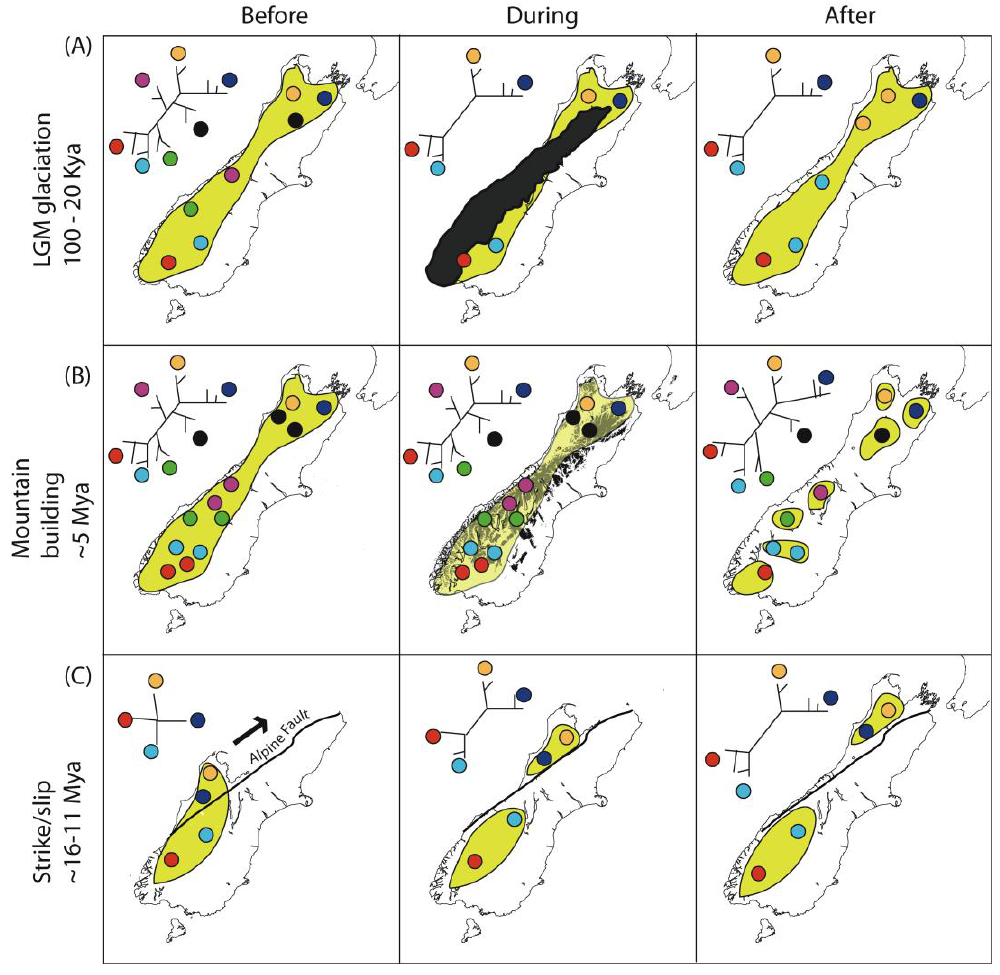
Figure 4. South Island ( A ) Habitat partitioning by glaciation, ( B ) Formation of alps, ( C ) Alpine fault displacement. On a long narrow island a widely distributed taxon is likely to develop a pattern of isolation by distance, even without any habitat heterogeneity. Geophysical processes may influence the gene genealogy among populations and species that evolve. Yellow area indicates range of hypothetical taxon. ( A ) Glaciation (black area) might cause extinction of some populations (and their genetic lineages), and partition residual populations in the north and south. Subsequent retraction of glaciers could allow expansion of forest taxa through leading-edge colonization; ( B ) Formation of alps (black areas) might yield habitat heterogeneity and reduce gene flow among populations leading to formation of allopatric species; ( C ) Alpine fault displacement (alpine fault line in black) might sunder adjacent populations enabling their independent evolution over time, resulting in similar phylogeographic structure resulting from lineage extinction